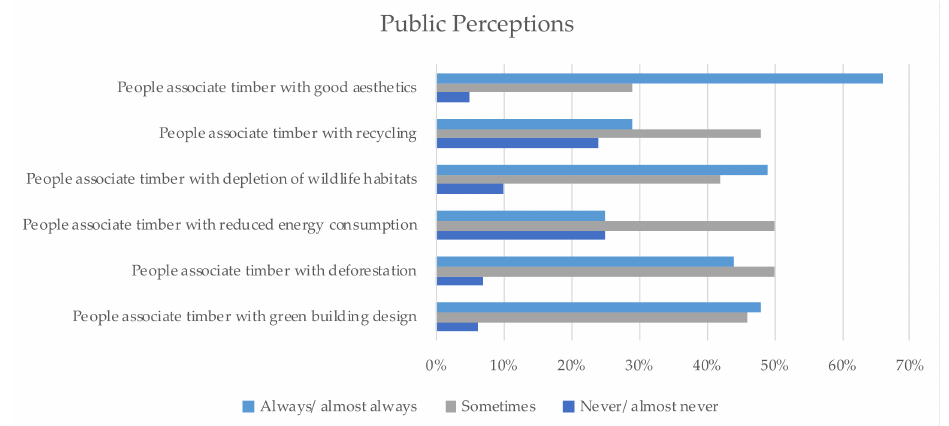
Figure 7. Responses to the question ‘In your opinion, how often are the following statements about public perceptions true?’.